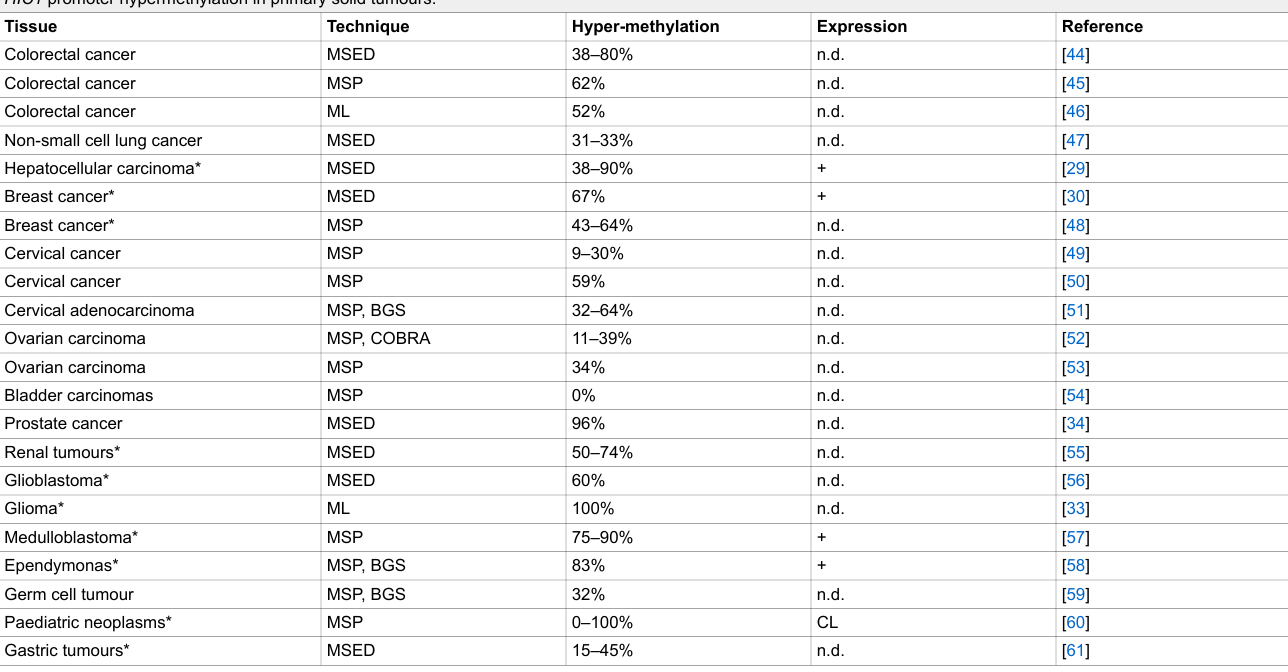
Table 1 HIC1 promoter hypermethylation in primary solid